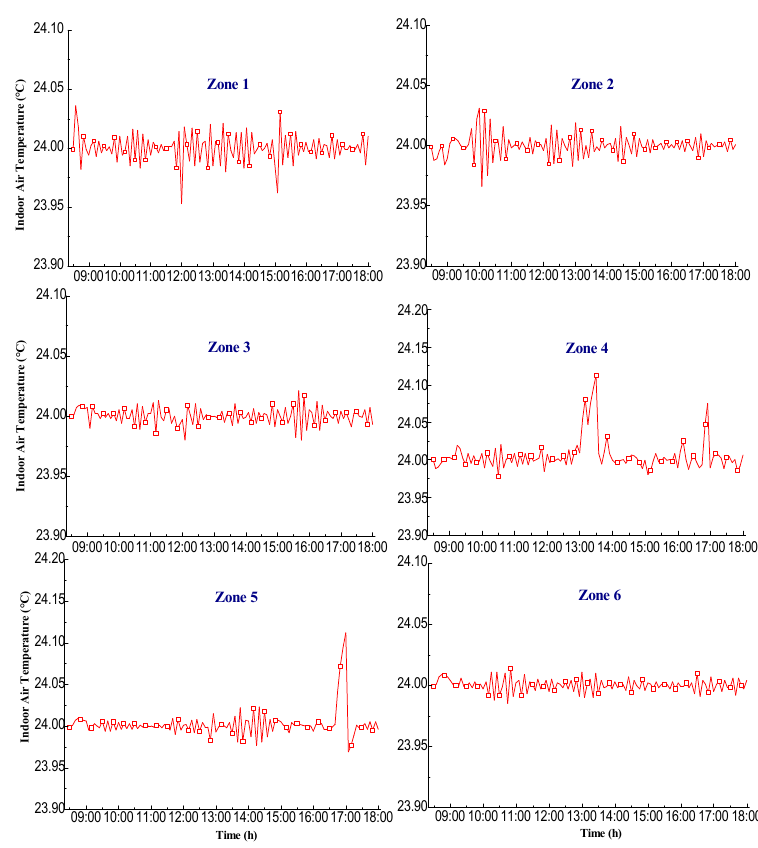
Figure 8. The indoor air temperature of six zones under Scenario 2.